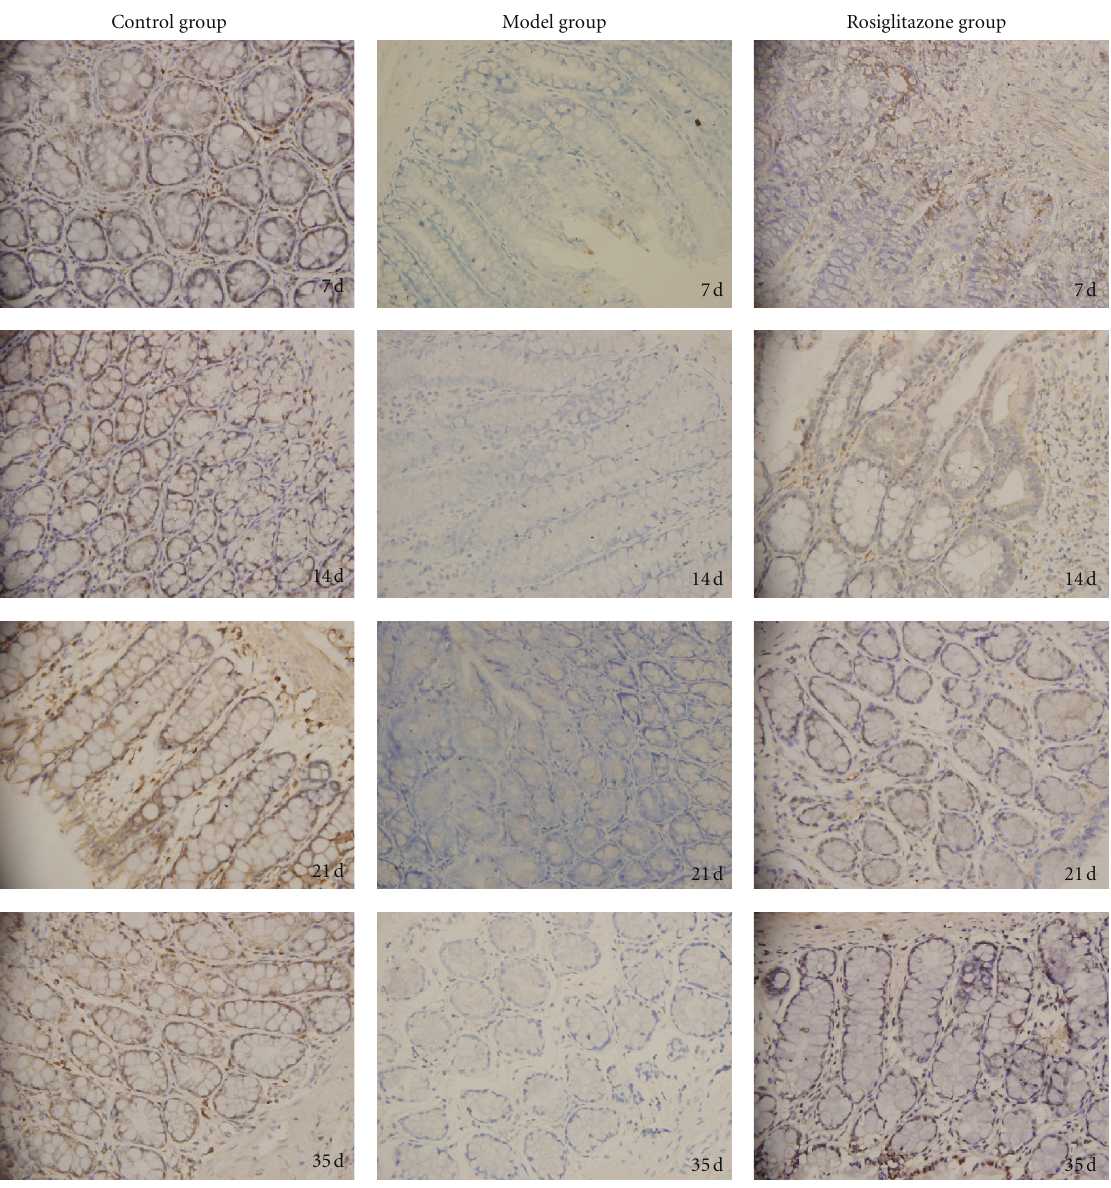
Figure 2: The colonic mucosal PPAR γ protein expression in the control group, UC model group, and rosiglitazone treated group on days 7, 14, 21, 35. In the control group, expression of PPAR γ protein in the colonic mucosa was significantly higher compared to the UC model group ( P < 0.05). In the rosiglitazone treatment group, PPAR γ protein expression increased significantly than that of the model group on days 7, 14, 21, 35 ( P <